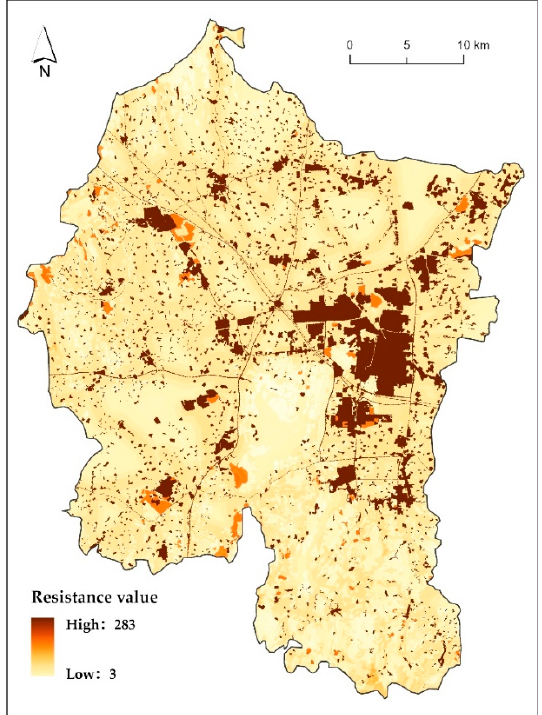
Figure 9. Comprehensive-resistance surface.